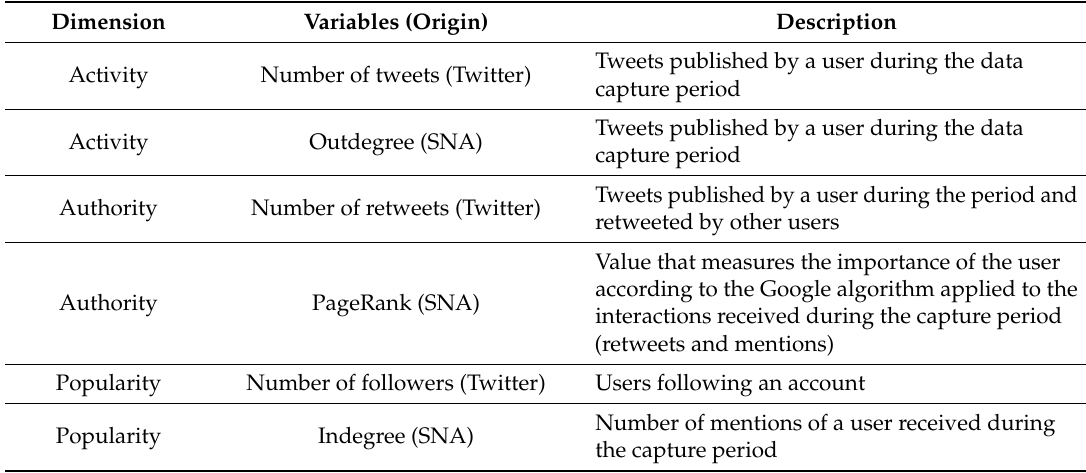
Table 2. Variables that make up each dimension of influence on